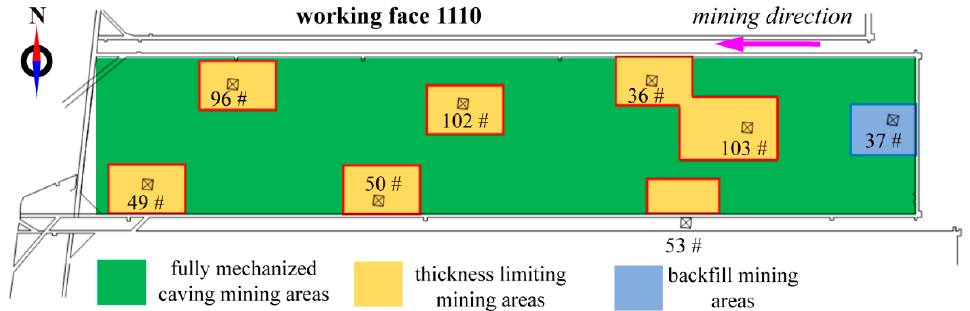
Figure 9. Diagram of the application area of the three different mining methods in working face 1110. The thickness-limiting mining areas and the backfill mining areas are defined as the key regions.